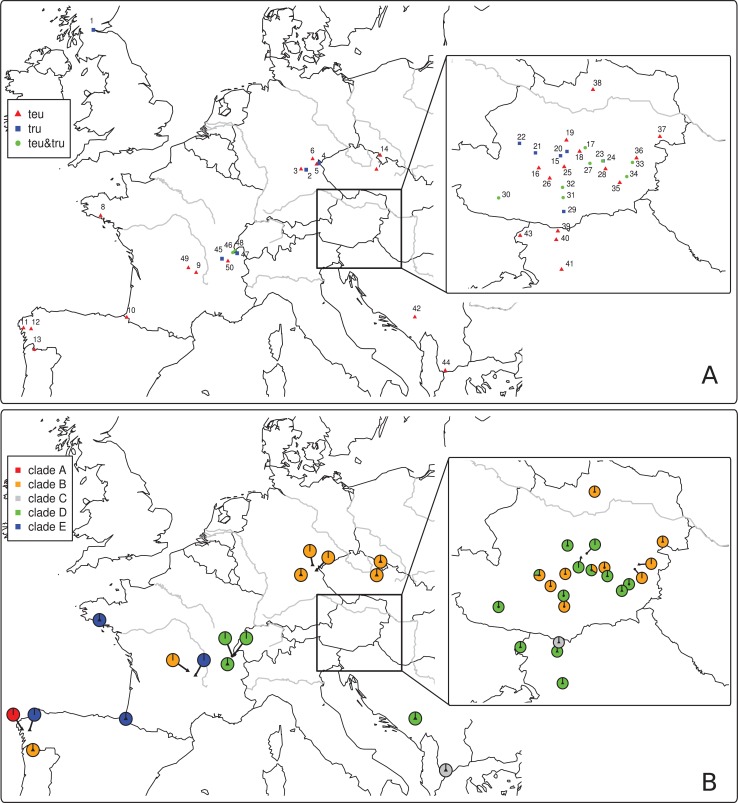
Maps illustrating (A) the principal sampling locations of the study (location numbers as in Table 1) as well as the occurrence of G. teuchis (red triangle), G. trutta (blue square), or both species (green circle) in a given location, and (B) depicting the geographic distribution of the five mtDNA clades (A-E, see Fig 2) of G. teuchis throughout the study area.The enlarged boxes represent sampling locations or mtDNA clade data in Austria and Slovenia.